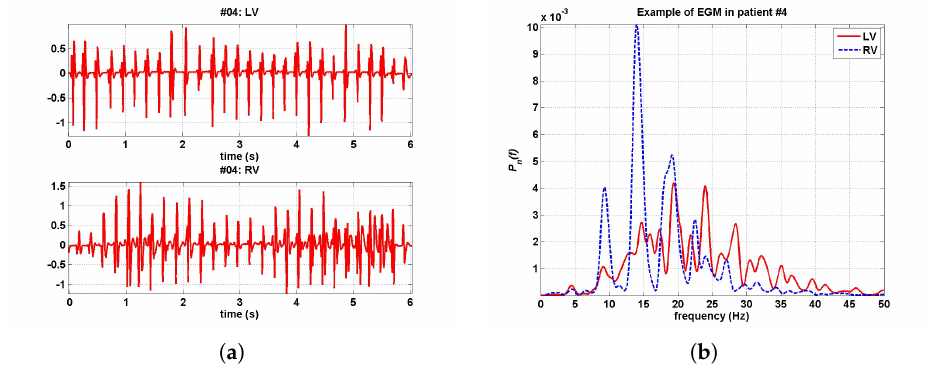
Figure 5. Example of EGM in RV and LV, in the time and frequency domains. ( a ) EGM simultaneously recorded in RV and LV. ( b ) Their corresponding spectra normalized to unit